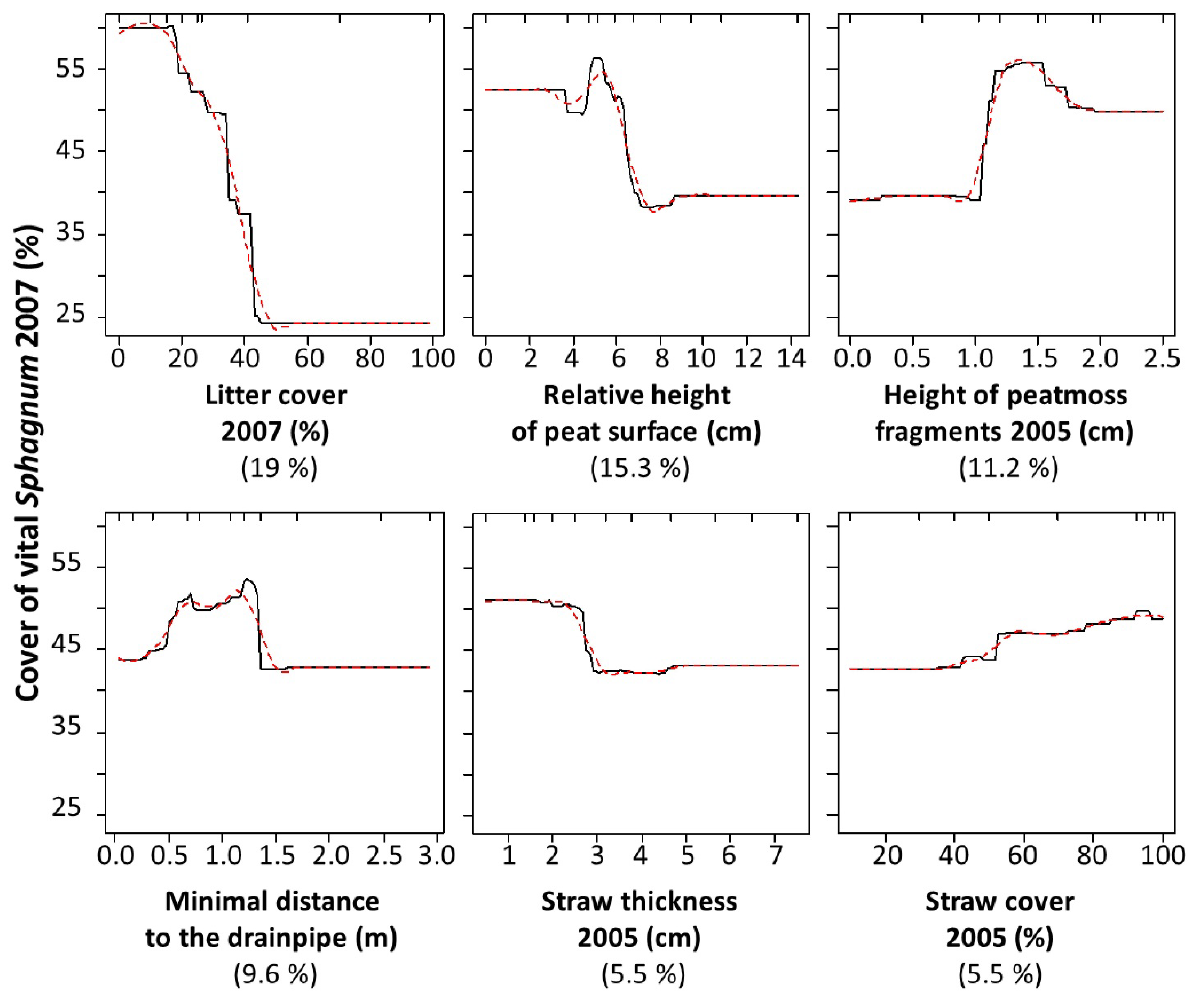
Figure 8. Boosted regression tree model of establishment expressed as cover (%) of vital Sphagnum papillosum 32 months after installation (July 2007, response variable) and its predictor/explanatory variables litter cover (%, July 2007), relative height of peat surface (cm above the lowest peat surface altitude), layer thickness of peatmoss fragments (cm, June 2005, 8 months after installation), minimum distance to an irrigation pipe (m), straw layer thickness (cm) and cover (%, June 2005). Percentages in the abscissa labels (in brackets) give the absolute contributions of individual variables to biomass productivity. The red (dashed) line is the smoothed relationship between the cover of vital peatmoss in 2007 and the individual explanatory variable. The vertical markers on the ‘box’ line at the top indicate real observations. The boosted regression tree model was performed with 60 observations and six predictors, using the Poisson distribution, with tree complexity = 2 (sets the complexity of individual trees, interaction order), learning rate = 0.005 (sets the weight applied to individual trees, shrinkage factor), and bag fraction = 0.75 (sets the proportion of observations used in selecting variables). The final model was fitted with 1050 trees and explained deviance = 0.66. No relationship was observed for cover of vital Sphagnum (%, June 2005, eight months after